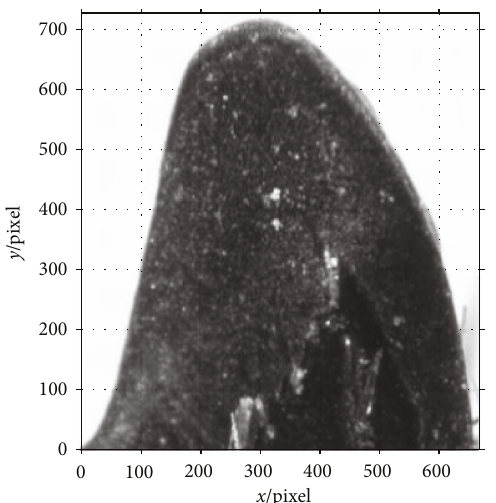
Figure 4: Original photograph of the end-tooth.